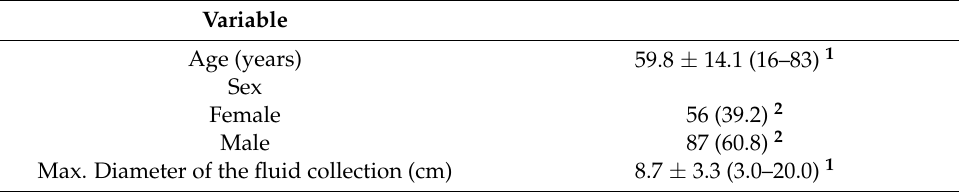
Table 1. Population characteristics in 143 patients having undergone CT-fluoroscopy guided percuta- neous drainage of fluid collections following liver